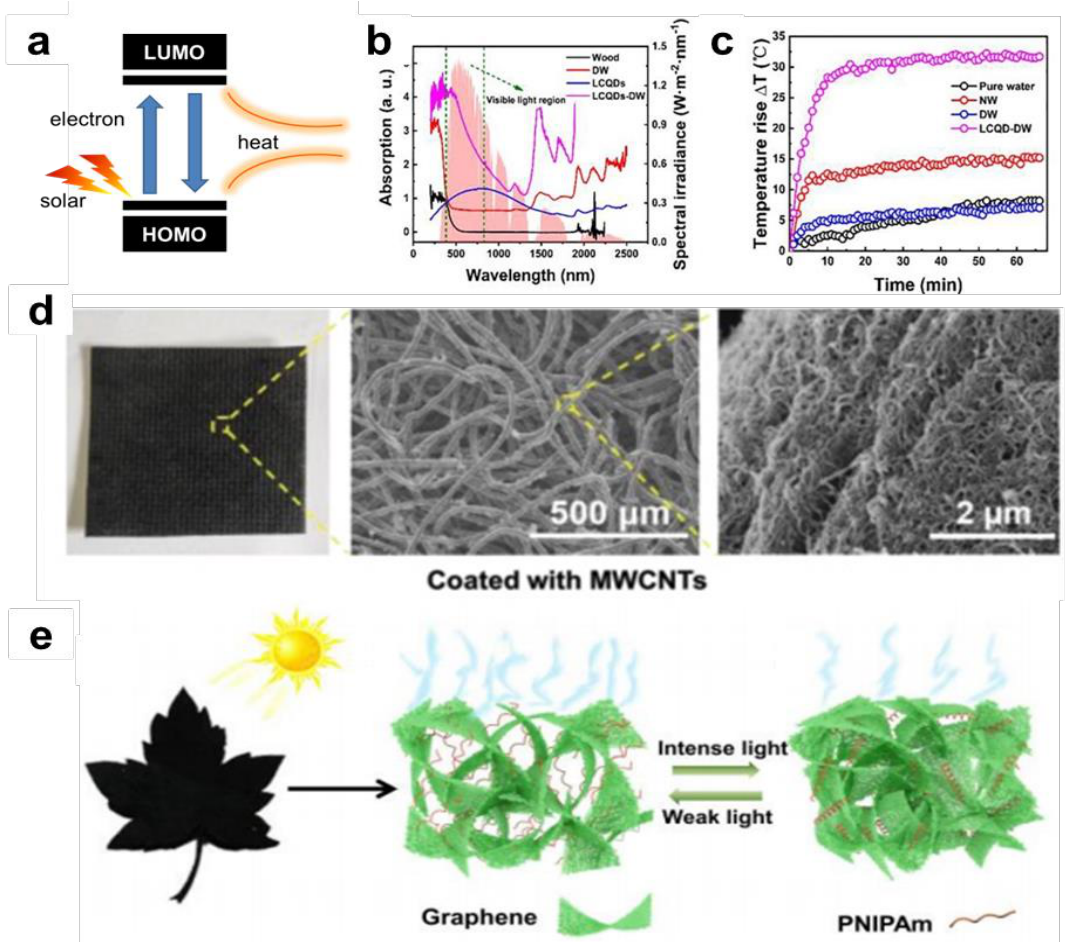
Figure 9. Carbon-based materials are used for photothermal conversion. ( a ) A schematic illustration of a carbon nanostructure with long internal optical-path lengths to enhance light absorption; ( b ) UV – Vis absorption of wood, DW, LCQDs, and LCQDs-DW. The standard AM 1.5 solar spectrum was set as the background and the visible light wavelength ranging from 380 nm to 780 nm was marked by a green dashed-line. Reprinted with permission from Ref. [95]. Copyright 2021 American Association for the Chemical Engineering Journal; ( c ) Temperature rising curve for pure water, wood, DW, and LCQDs-DW. Reprinted with permission from Ref. [95]. Copyright 2021 American Association for the Chemical Engineering Journal; ( d ) Photographs and SEM images of nonwoven (inset is the cross-section SEM image of PP/PE fiber) with MWCNTs. Reprinted with permission from Ref. [98]. Copyright 2021 American Association for the Advanced Science; ( e ) Under the dif- ferent intensity of solar irradiation, the water transport channels can be autonomously turned on and off by the opening and closing of microstructures. Reprinted with permission from Ref. [100]. Copyright 2018 American Association for the Angewandte Chemie-International Edition .